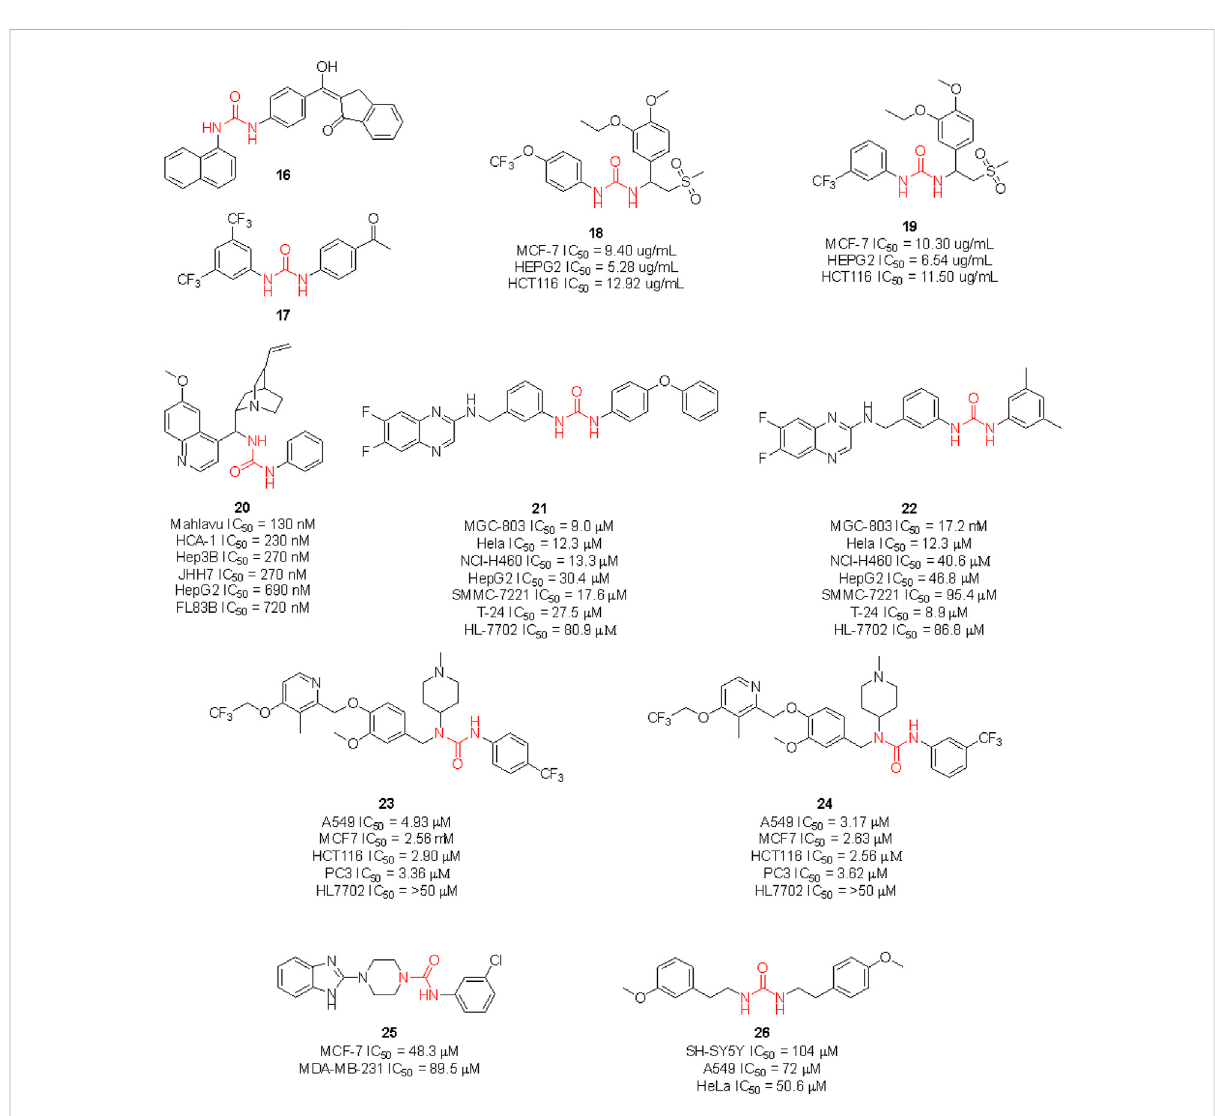
FIGURE 14 Urea-containing anticancer agents discovered in medicinal chemistry research programs within the last 2 years.